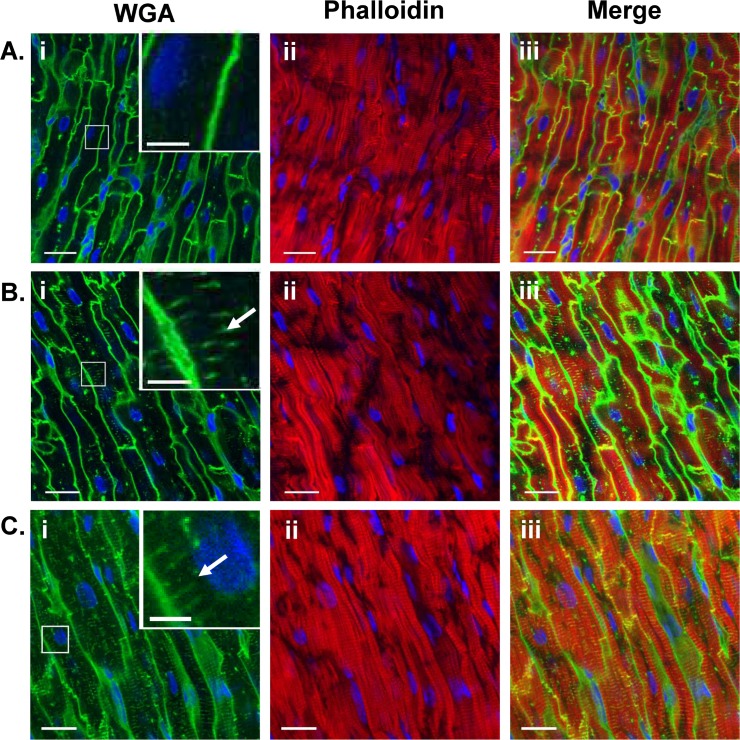
T-tubules in fixed sections of pig atrial and ventricular tissue.Representative examples in the longitudinal plane. Pig atrial tissue without extensive t-tubules (A), pig atrial tissue with extensive t-tubules (B) and ventricular tissue (C) stained with Alexa Fluor-488 WGA (green; i) and Alexa Fluor-633 phalloidin (red; ii). Overlay shown in (iii). Inserts in (i) show detail at a higher magnification. DAPI staining shown in blue in all images. Scale bars represent 17 μm.